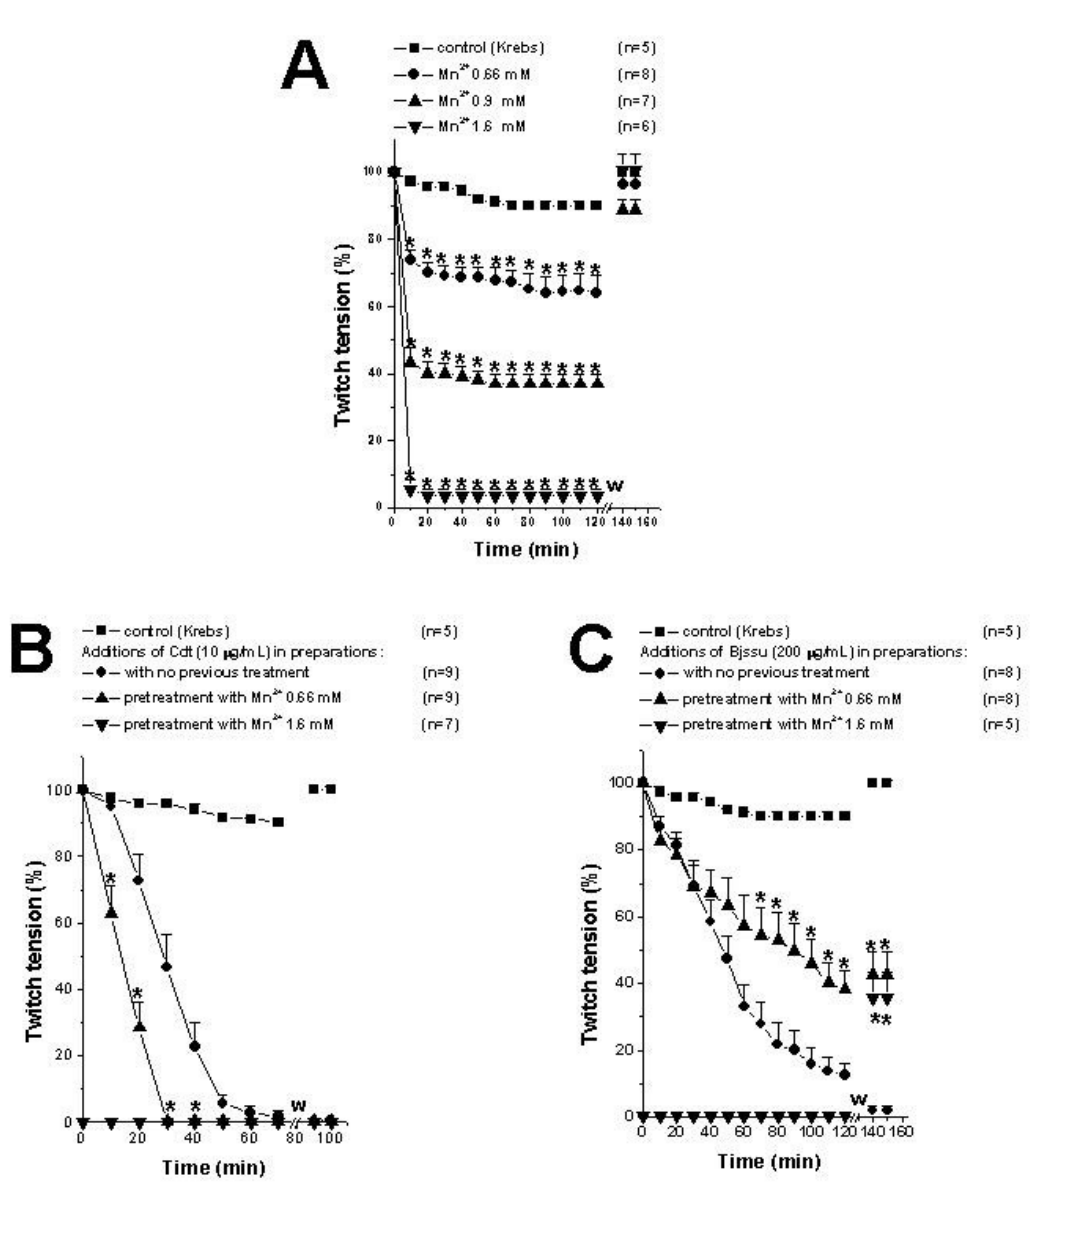
Figure 1. Chick biventer cervicis preparation (indirect stimuli). ( A ) Concentration-inhibition curve of Mn 2+ ions. ( B ) Effects of Crotalus durissus terrificus (Cdt) venom alone and after pretreatment with Mn 2+ (0.66 and 1.6mM). ( C ) Effects of Bothrops jararacussu (Bjssu) venom alone and after pretreatment with Mn 2+ (0.66 and 1.6mM). Note that Mn 2+ did not hinder the neuromuscular blockage caused by Cdt venom but partially reduced that caused by Bjssu venom. Blockages induced by 0.66mM (partial) and 1.6mM (total) Mn 2+ in the first 20min were not indicated in order to emphasize the effect produced after the addition of whole venoms. Each point represents the mean ± S.E.M. of the number of experiments indicated in parentheses. * p<0.05, compared with control ( A ) and with Bjssu ( B ) and Cdt ( C ) venoms alone. After washing (W), preparations were kept in nutritional solution